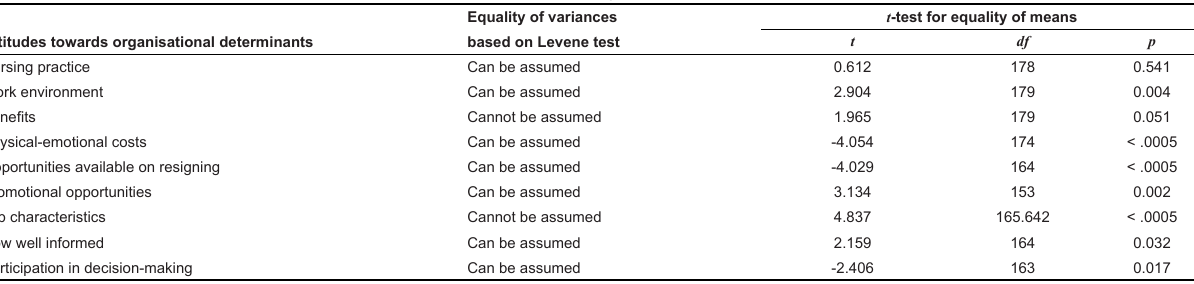
TABLE 8 Independence sample test: Organisational determinants Equality of